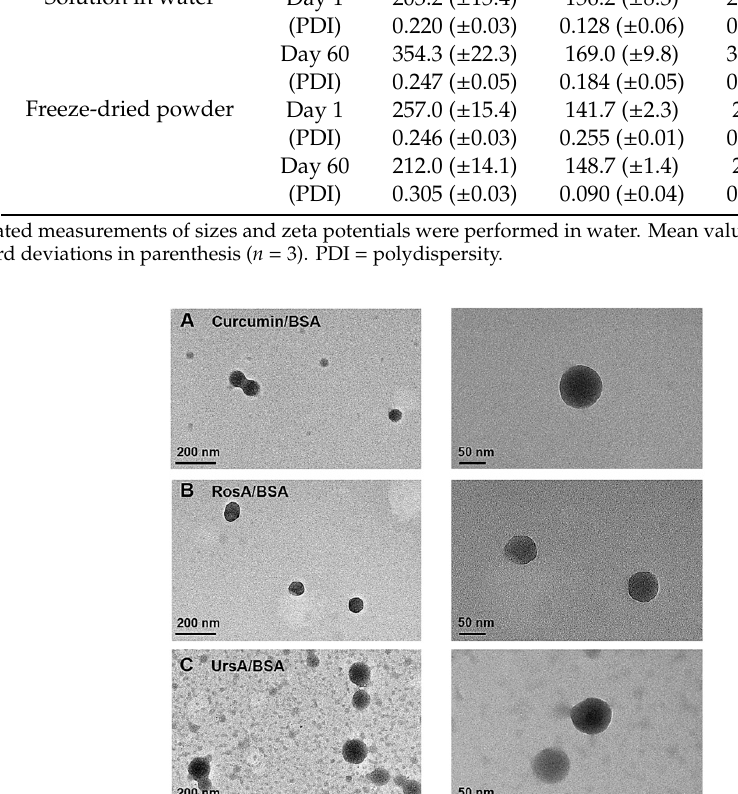
Table 1. Particle size and zeta potential measurements of bovine serum albumin (BSA) particle formulations containing curcumin, rosmarinic acid (RosA), or ursolic acid.